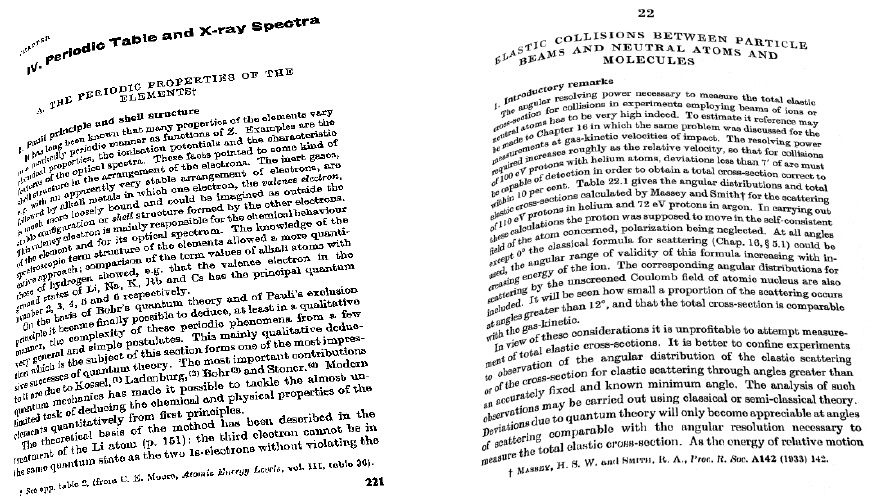
Figure 1. Example of document-image warping.